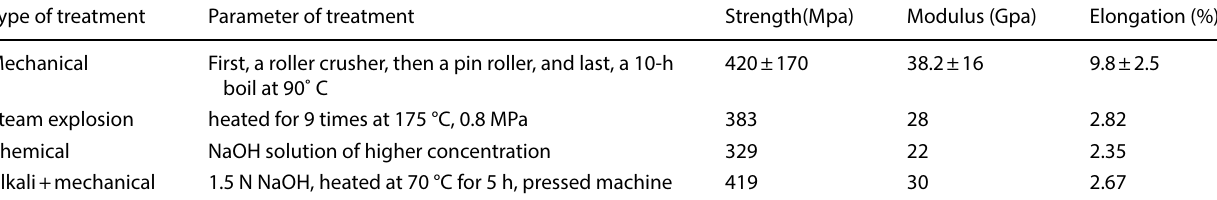
Table 2 Effect of extraction technique on the fiber properties [31–34] Type of treatment Parameter of treatment